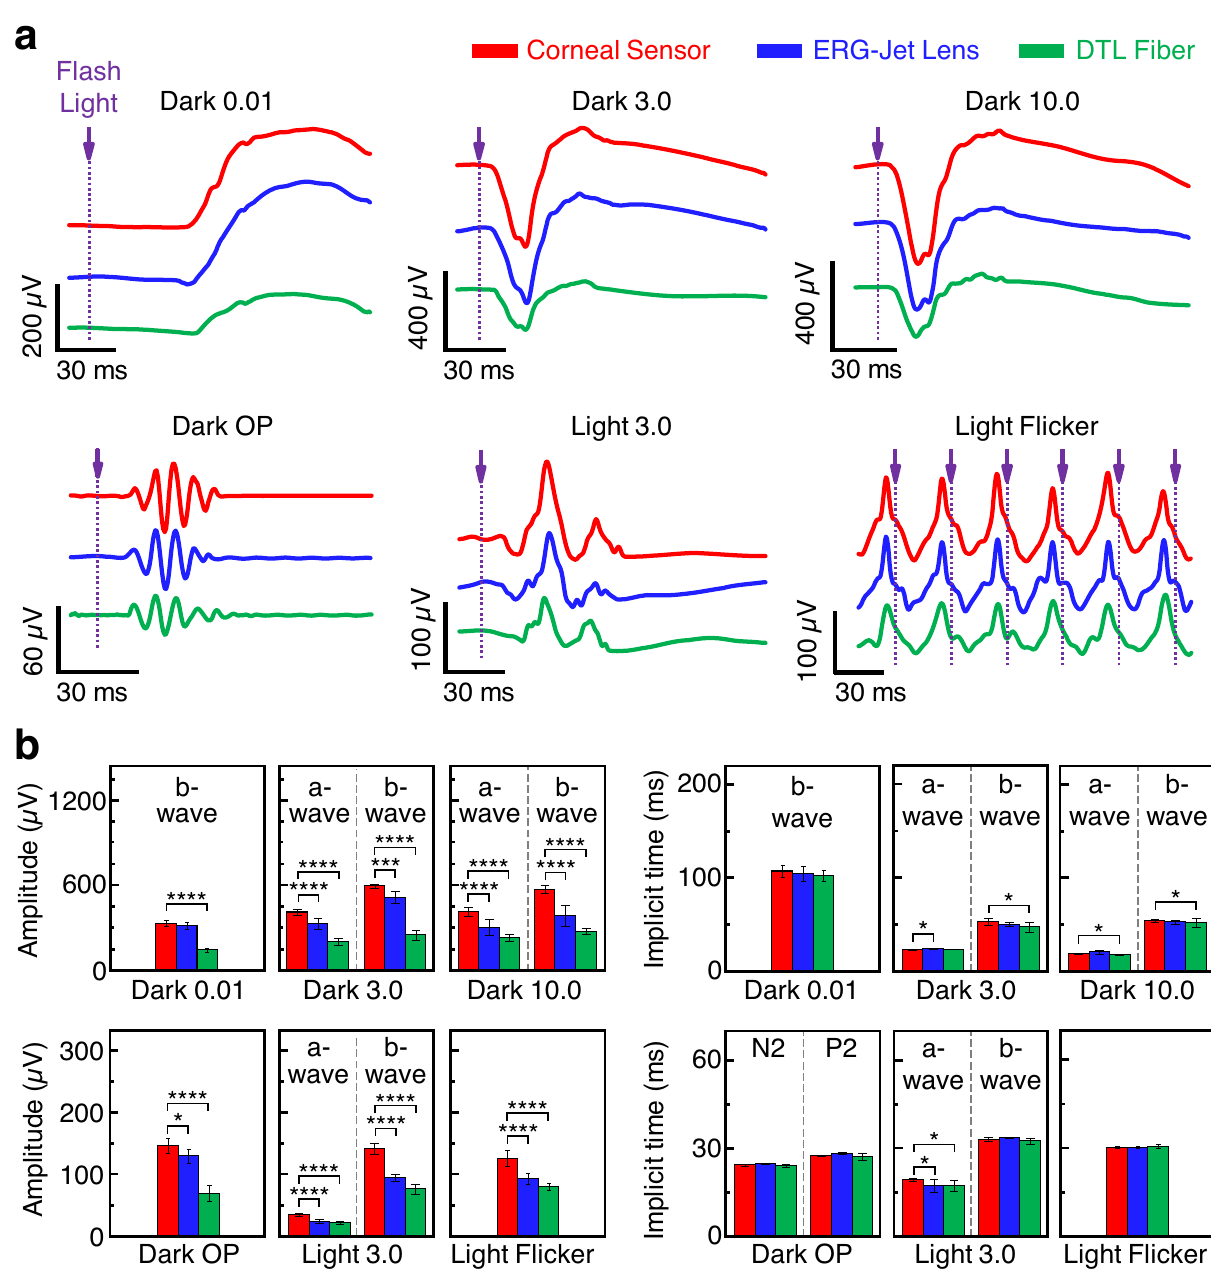
Fig. 5 ISCEV standard full- fi eld ERG recordings in a human eye. a ISCEV standard full- fi eld ERG signals acquired from the corneal sensor (red lines) by comparisons with those obtained using the ERG-Jet lens (blue lines) and DTL fi ber (green lines). b Summary of average amplitudes (left column) and implicit times (right column) extracted from each ERG protocol. The number of recordings for each protocol was 8 (Dark 0.01), 10 (Dark 3.0), 10 (Dark 10.0), 8 (Dark OP), 8 (Light 3.0), and 9 (Light Flicker), respectively. For data analysis, a one-way analysis of variance (ANOVA) method with the Tukey ’